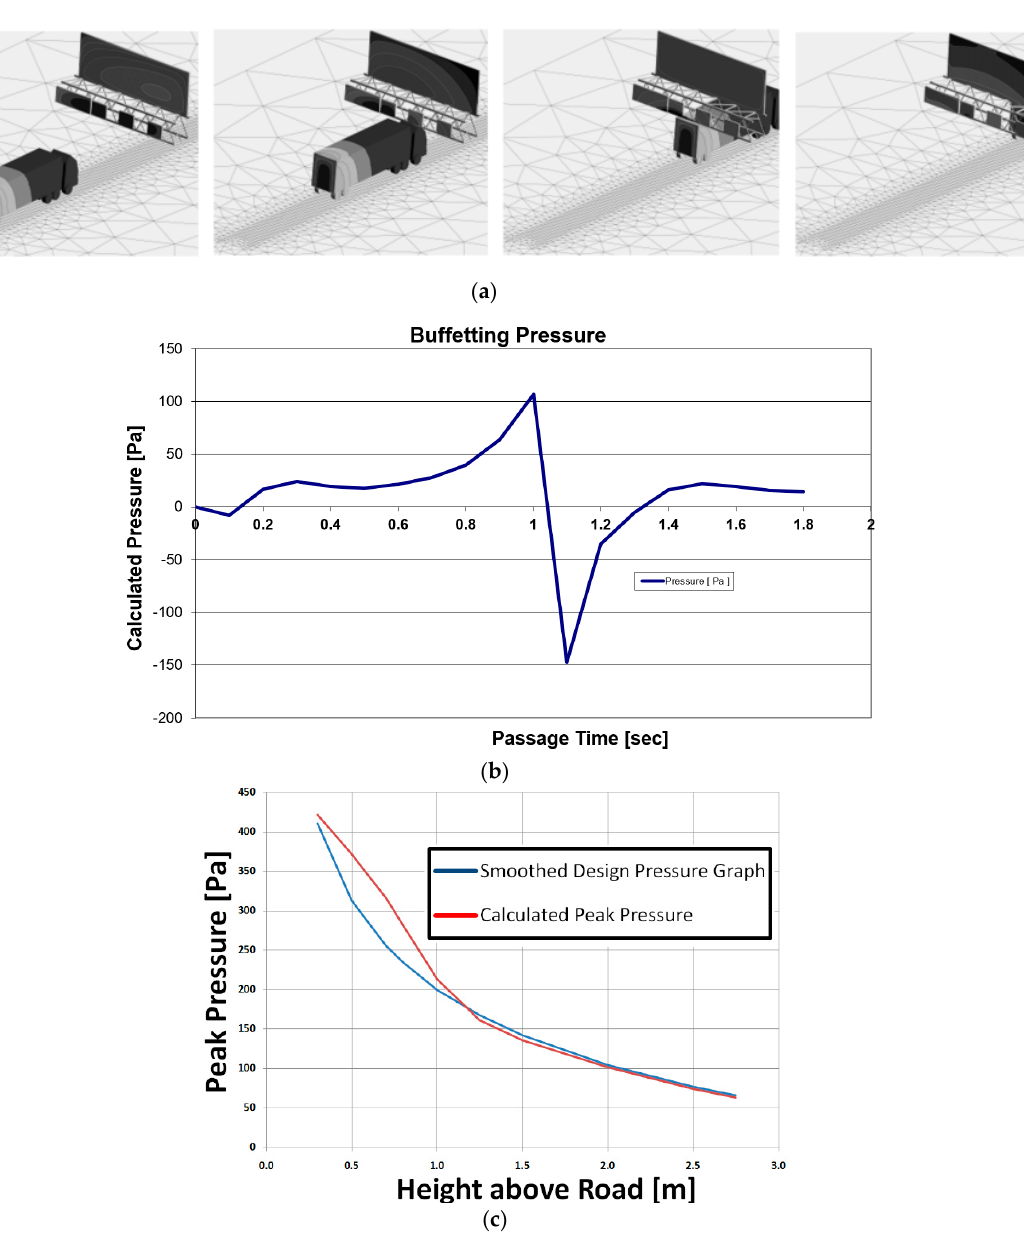
Figure 11. ( a ) Snapshots of HSV passage under gantry boom, ( b ) calculated time-history pressure results, and ( c ) calculated peak pressure and its smoothed design curve.